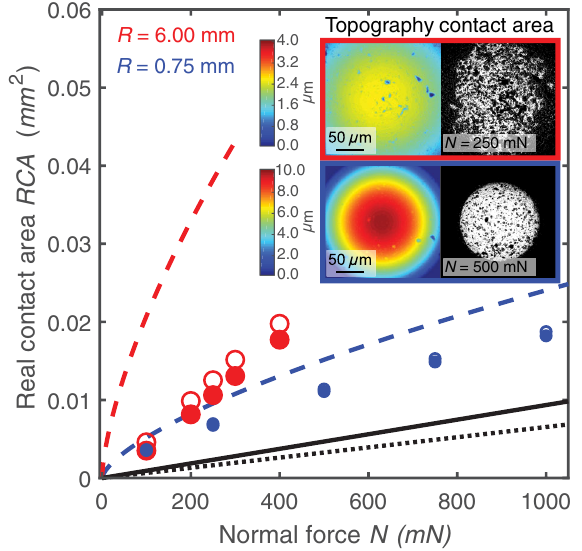
FIG. 9. Contact mechanics of the SiC spheres sliding on ice and RCA as a function of normal force N for a sphere with a radius of 6.00 mm (red) and 0.75 mm (blue) at temperatures of − 50 °C (open circles) and − 90 °C (closed circles). The dashed lines represent the elastic Hertzian pressure. The solid and dotted lines are, respec- tively, the plastic limit set by the penetration hardness at temper- atures of − 50 °C and − 90 °C. Inset: surface topography (left) and calculated area of real contact (right) for the SiC spheres.